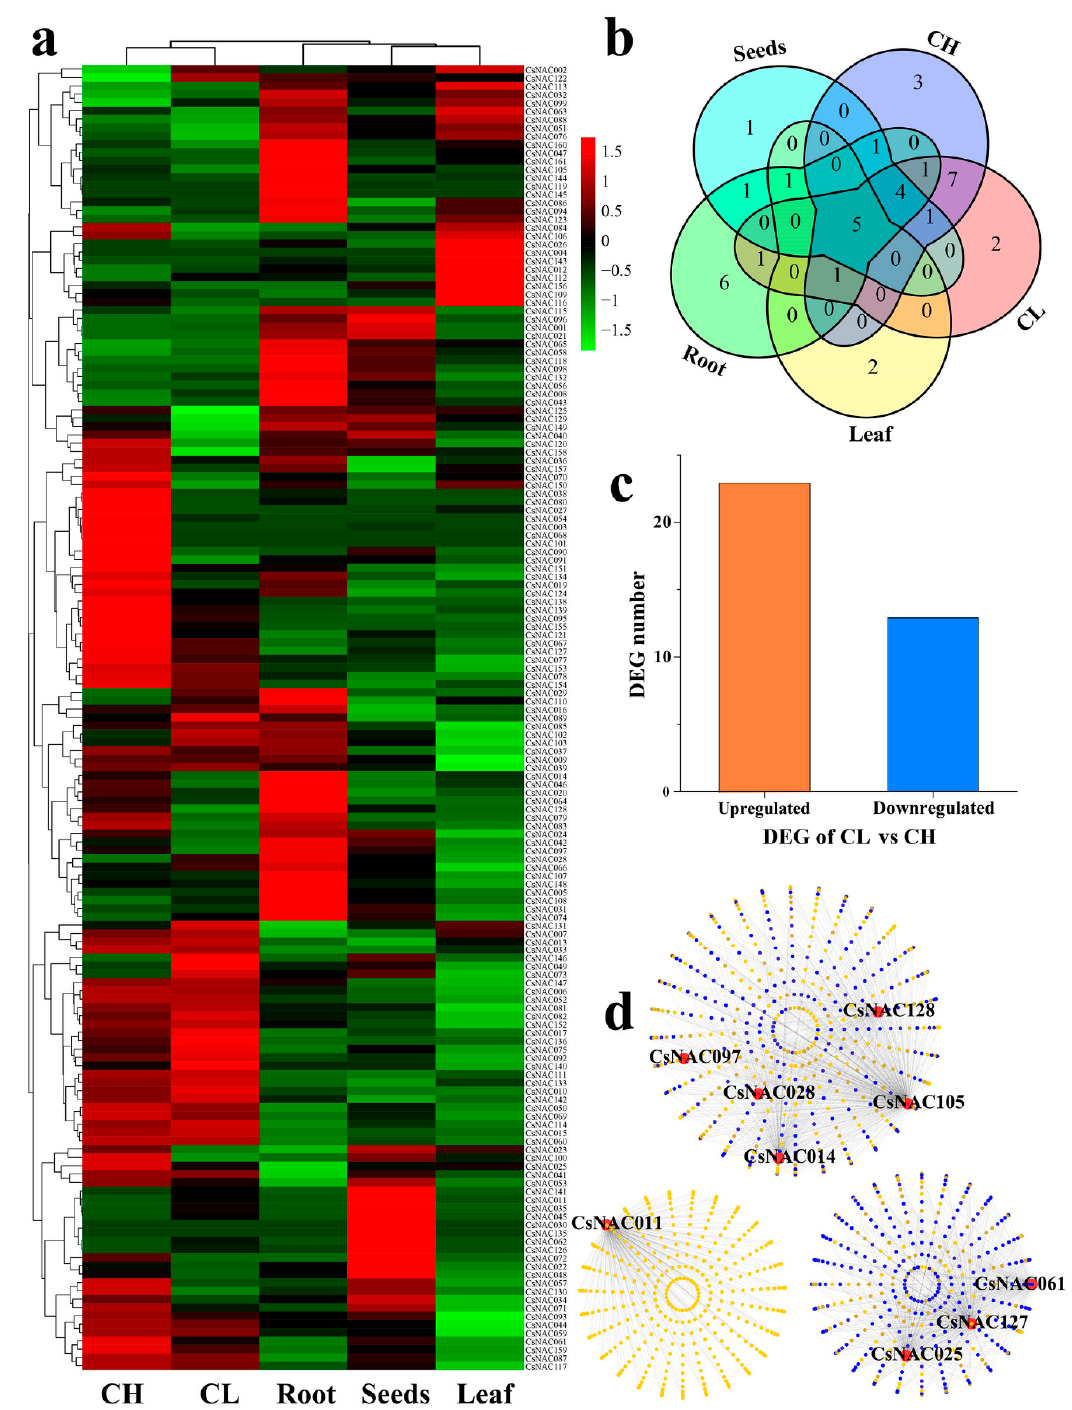
Figure 7. Expression profiles and coexpression network of CsNAC TFs during dimorphic floret development. ( a ) Hierarchical clustering of CsNACs in multiple organs based on transcriptome data. ( b ) The highly expressed CsNACs (FPKM ≥ 20) in multiple organs was marked by the overlapping petal circle. ( c ) The number of up-regulated and down-regulated CsNAC differentially expressed genes (DEGs) in dimorphic florets development. ( d ) Coexpression network of CsNAC DEGs between cleistogamous (CL) and chasmogamous (CH) flowers. The light yellow points represent individual genes. The blue points represent overlapping genes. The dark yellow points represent yellow points overlying blue points.